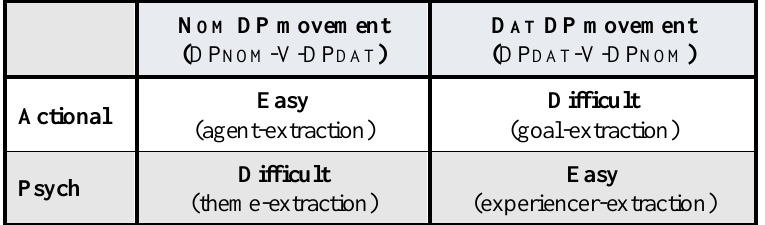
Table 1. Predictions of comprehension by verb type and extracted phrase type according to structure-based